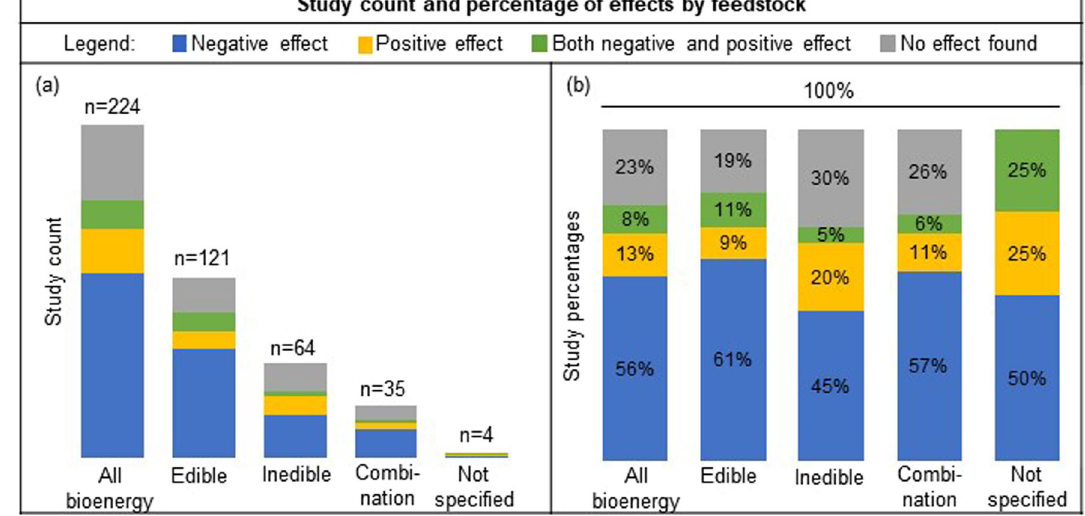
Fig. 1 Publication count and percentage of effects by bioenergy feedstock. The count ( a ) and percentage ( b ) of publications that reported a negative, positive, combination of both negative and positive, and neutral effect of bioenergy expansion on overall food security with all bioenergy, edible, inedible, a combination of both edible and inedible bioenergy, and bioenergy type not speci fi